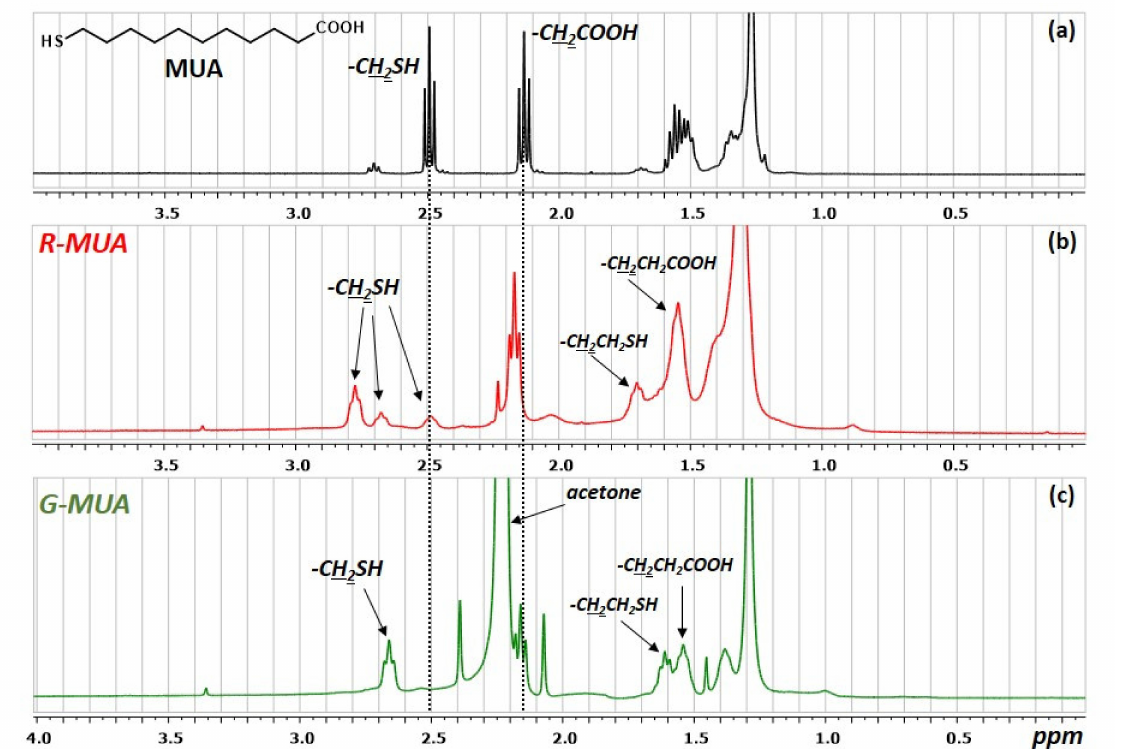
Figure 3. 1 H NMR spectra of MUA (in NaOD/D 2 O) ( a ) and D 2 O dispersion of AgInS 2 -ZnS nanocrystals capped with MUA : R-MUA ( b ) and G-MUA ( c